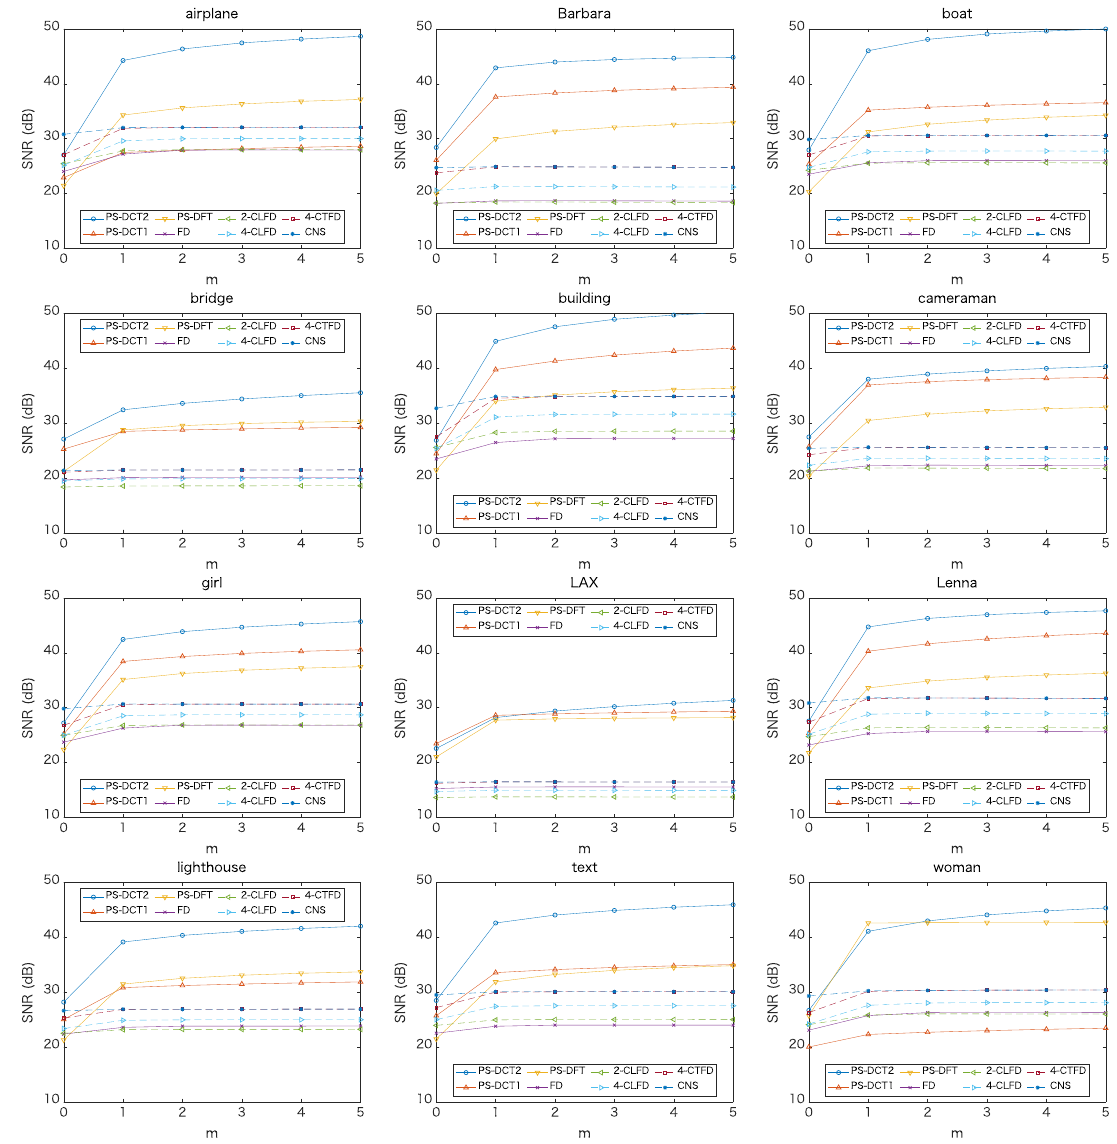
Figure 4. SNRs of the final output when excluding m columns on both sides of the